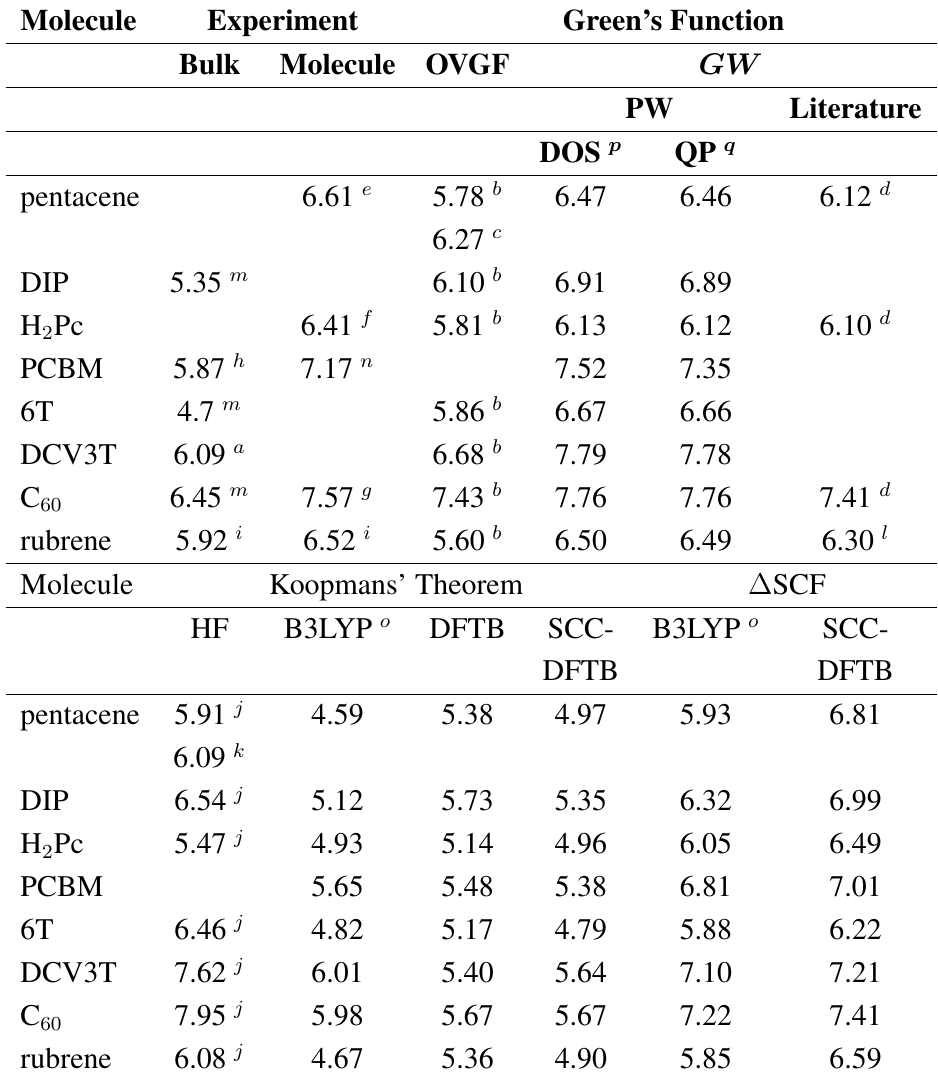
Table 5. Comparison values of the first ionization potential for the medium-sized molecules from experiment and from quantum chemistry calculations. OVGF, outer-valence Green’s